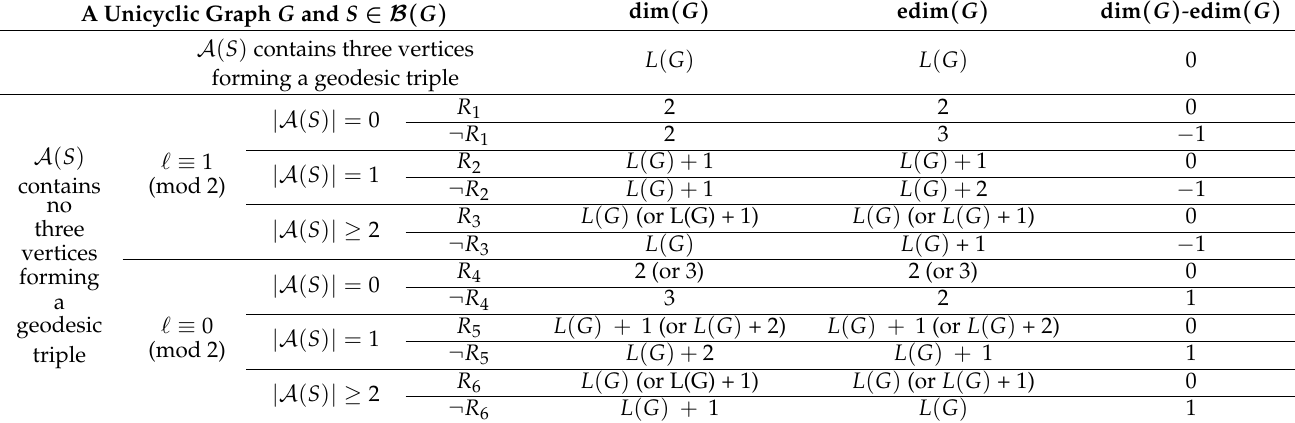
Table 1. Metric dimension and edge metric dimension of unicyclic graphs, and their relation.